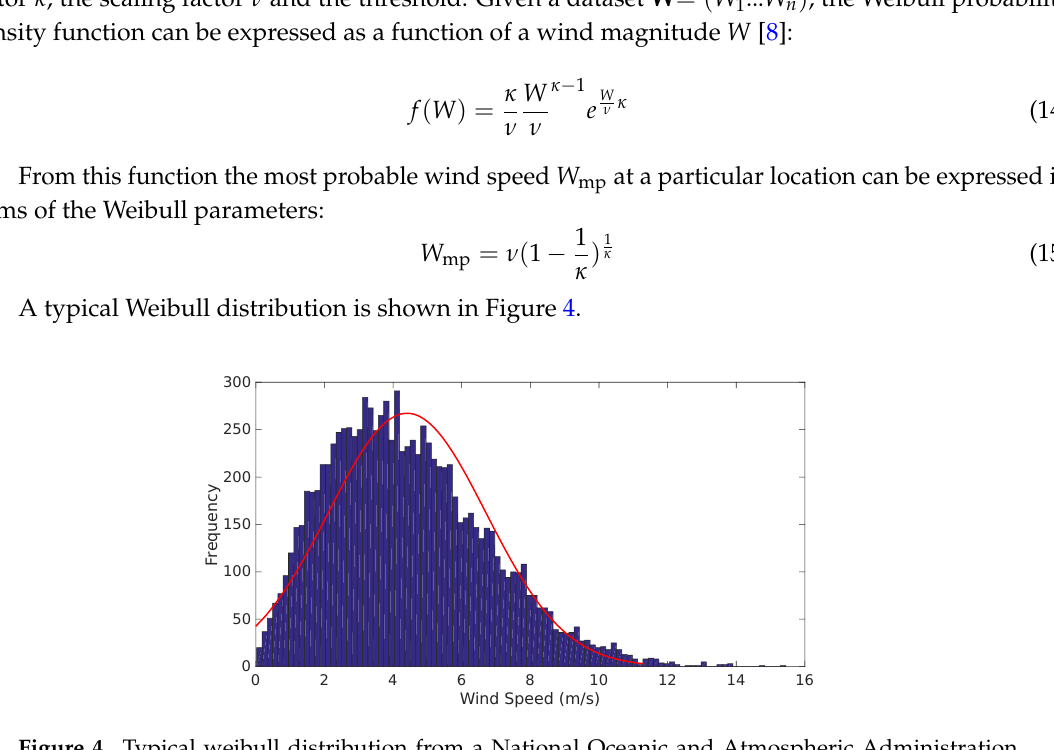
Figure 4. Typical weibull distribution from a National Oceanic and Atmospheric Administration (NOAA) measurement station at an altitude of